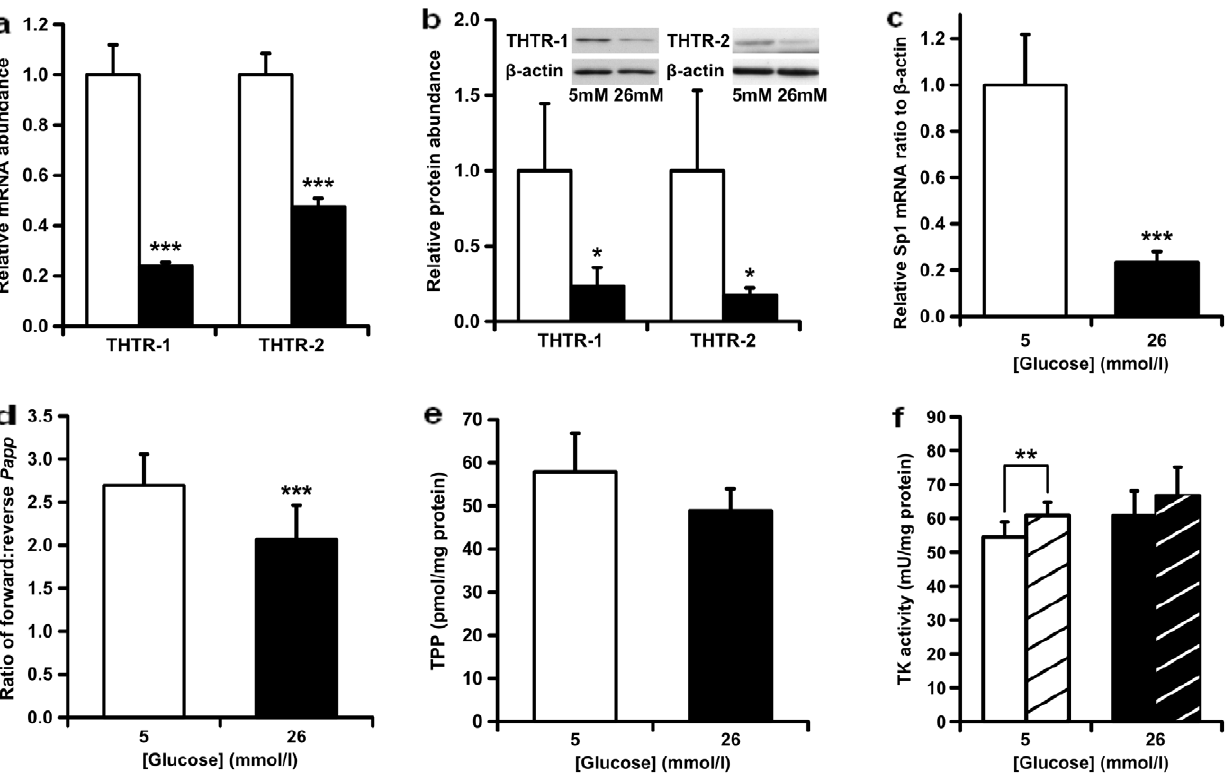
Figure 2. Effect of glucose concentration on thiamine-related metabolism in human tubular epithelial cells in primary culture. a mRNA of SLC19A2 and SLC19A3 genes, relative to b -actin (n=8). b THTR-1 and THTR-2 protein in membrane extracts, relative to b -actin (n=4). c Effect of glucose concentration on expression of transcription factor Sp1. Sp1 mRNA level was normalized to b -actin mRNA. Data are mean 6 SD (n=8). d Ratio of forward to reverse thiamine apparent permeability P AppF/R . e Cellular concentration of TPP. f Transketolase activity. Key: hPTECs in primary culture for 5 days with 5 mmol/l glucose (hollow bars), 26 mmol/l glucose (filled bars), and addition of 350 m mol/l TPP in the TK activity assay (striped bars). Data are mean 6 SD (n=8, 4, 8, 6, 8 and 8 for a – f , respectively). Significance: *, P , 0.05; **, P , 0.01 and *** P , 0.001.